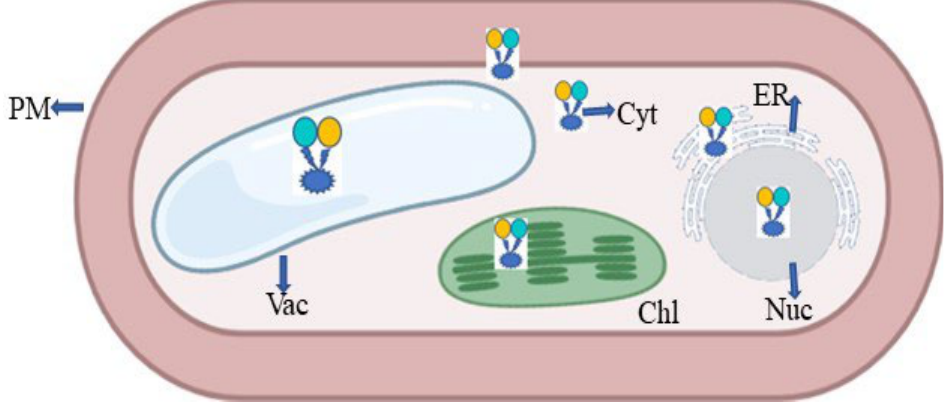
Figure 11. Expression of FRET in the form of nanosensor in a plant cell; PM—plasma membrane; ER—endoplasmic reticulum; Chl—chloroplast; Vac—vacuole; Nuc—nucleus; Cyt—cytoplasm.